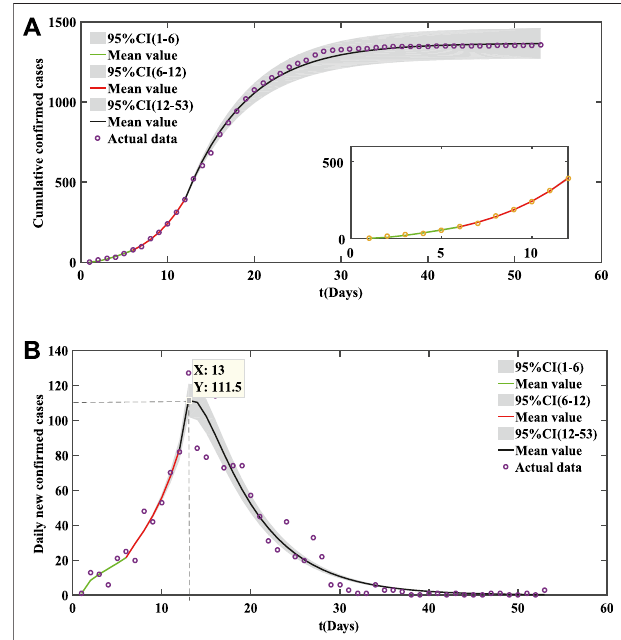
FIGURE 4 | Fitting results of cumulative COVID-19 cases in Guangdong Province. (A) Cumulative con fi rmed cases. (B) Daily new con fi rmed cases. Initial value of parameter: S (0) (cid:2) 1.1521 × 10 8 [29], E ( 0 ) (cid:2) 220 , I ( 0 ) (cid:2) 10 , Q ( 0 ) (cid:2) 1 , R ( 0 ) (cid:2)